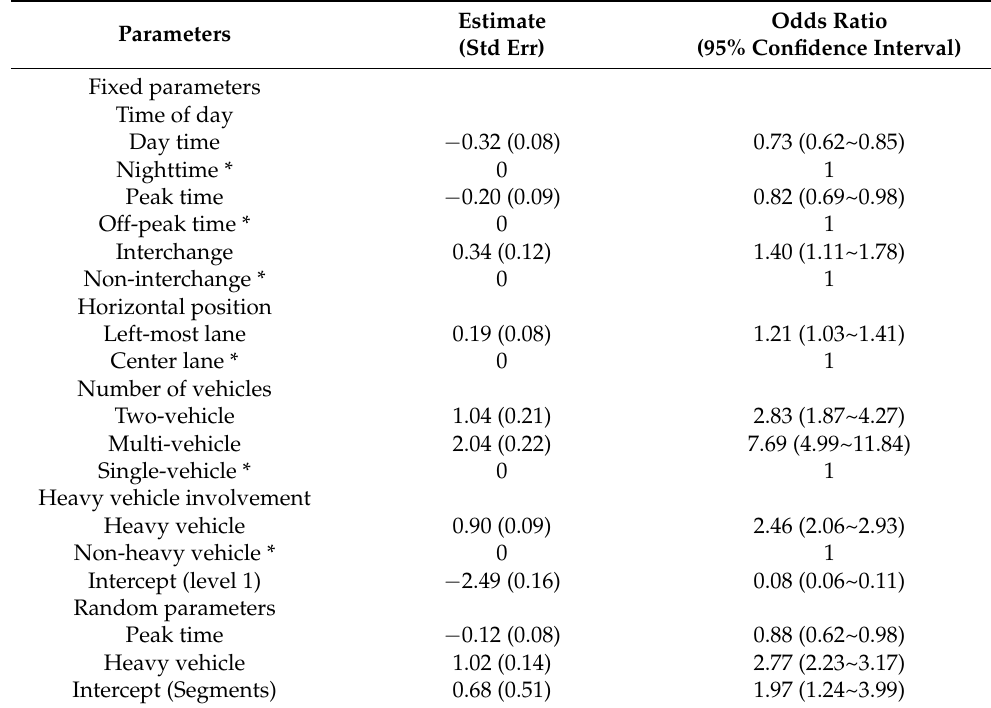
Table 4. Estimation results for crashes on two-way six-lane